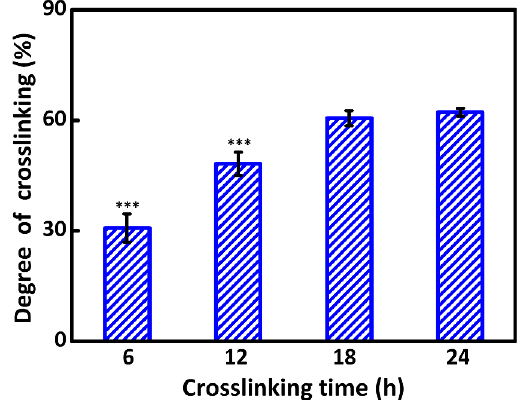
Figure 2. Analysis of degree of crosslinking introduced into collagen nanofibrous membranes as a function of the crosslinking time (Significant differences were marked by *** for p < 0.001 compared to the 18 h and 24 h